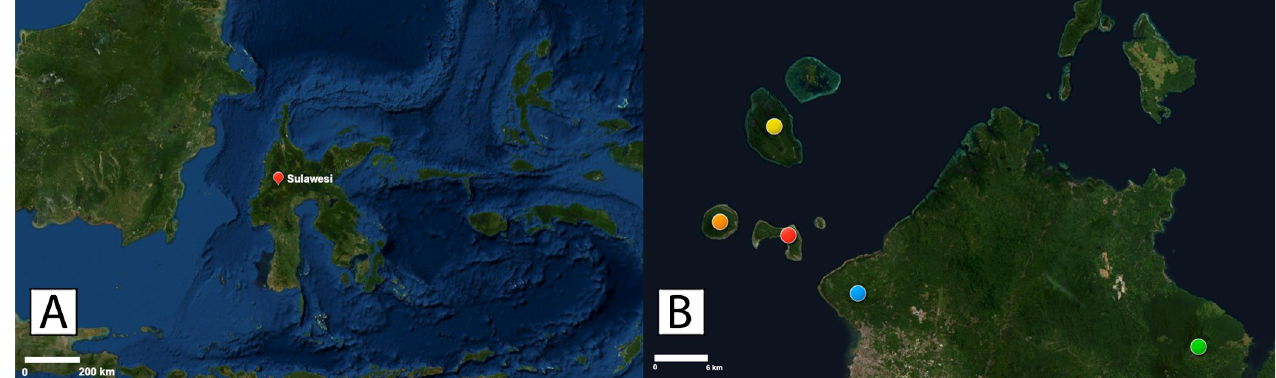
Fig 1. The maps of Sulawesi and parts of North Sulawesi. A) Sulawesi, the fourth largest island in Indonesia, hosts many endemic animals. The “hybrid biogeography hypothesis” (Shekelle and Leksono, 2004) suggests that there are at least 16 subregions of tarsier endemism throughout the island. B) Grand forest park Gunung Tumpa (blue circle), Duasudara Nature Reserve (green circle), and three islands in TNB: Bunaken (red circle), Manadotua (orange circle), Mantehage (yellow circle).